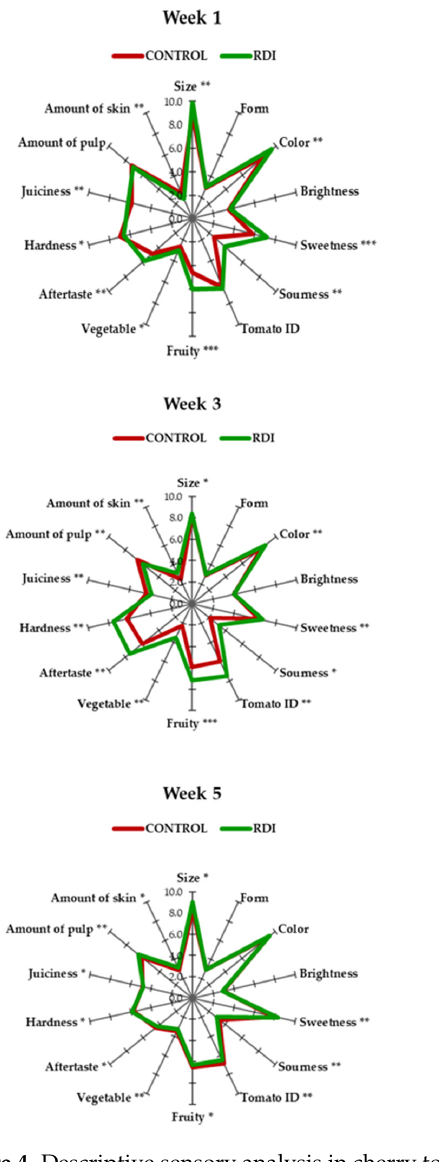
Figure 4. Descriptive sensory analysis in cherry tomato samples * p < 0.05, ** p < 0.01 and *** p <